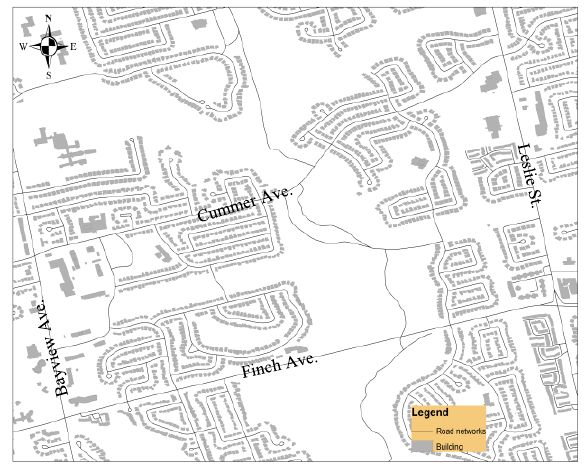
Figure 2. Location for the study area